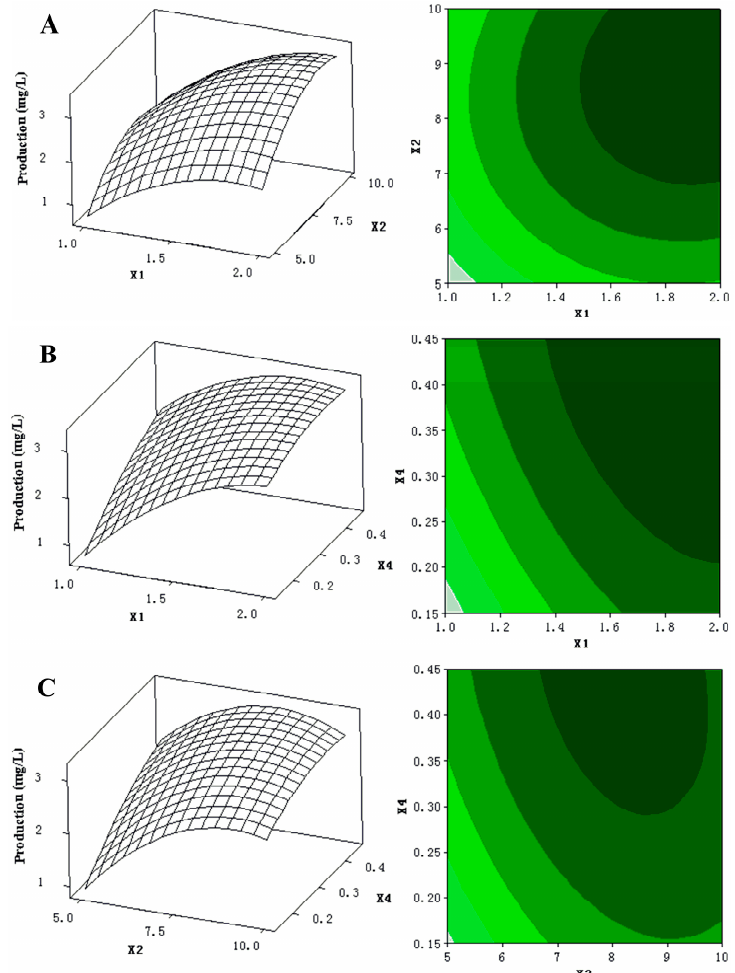
Figure 3. ( A ) 3D response surface curve ( left ) for production (streptochlorin) affected by yeast extract